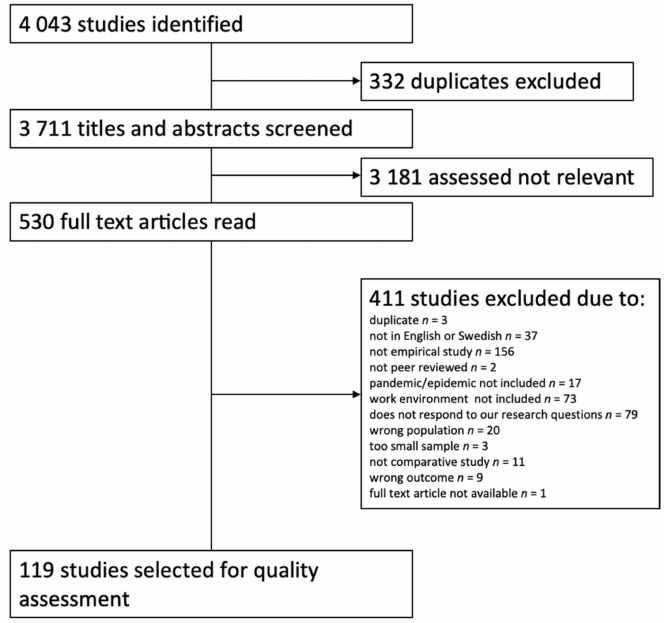
Figure 1. Flowchart of the selection and exclusion of